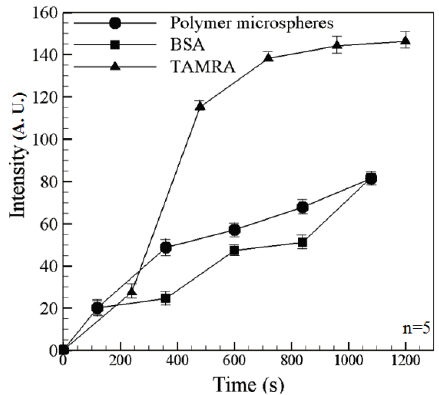
Figure 10. Fluorescence intensity curves of polymer microspheres, BSA and TAMRA at each time point. Data points represent the mean of five measurements, and the error bars represent one standard deviation from the